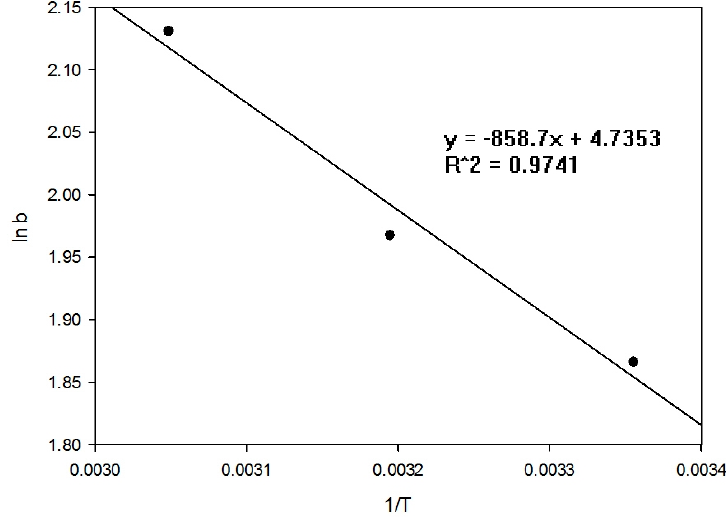
Figure 7. Plot of lnK vs. 1/T for estimation of thermodynamic parameters (∆H° and ∆S°) .